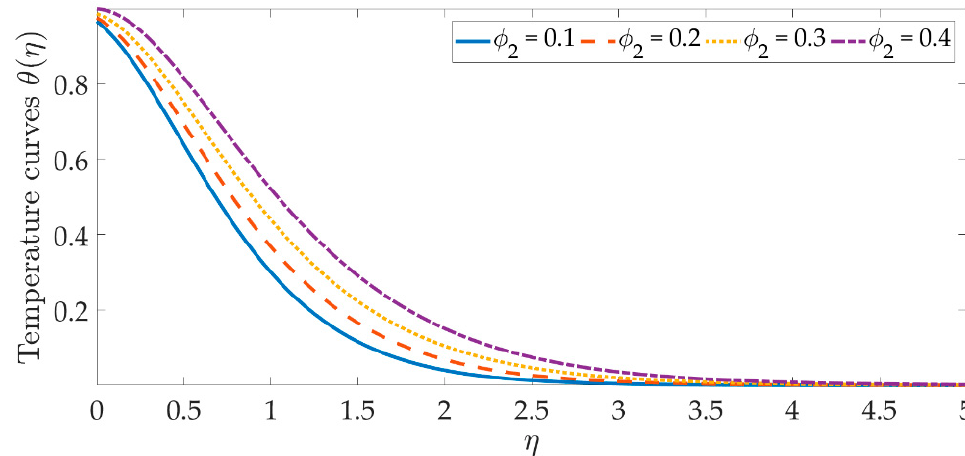
f Figure 7. Temperature curves against the multiple values of φ 2 .